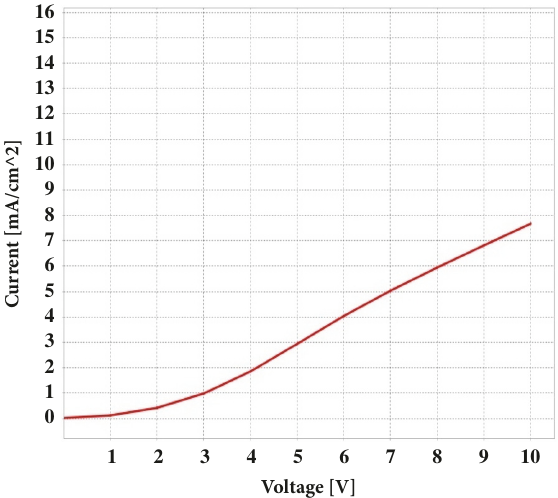
Figure 3: JV plot of device